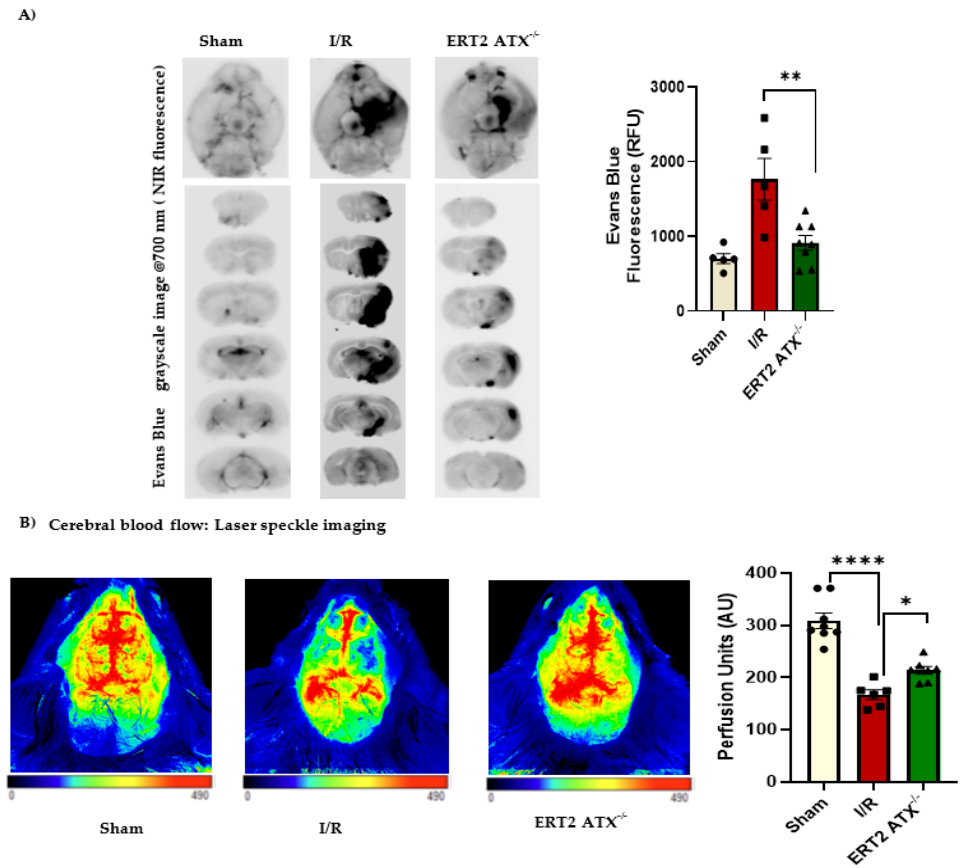
Figure 6. Better functional stroke outcomes observed in ERT2 ATX − / − mice. ( A ) Vascular permeability measured using Evans blue fluorescence. Evans blue fluorescence obtained at 700 nm in the infrared imager represented as grayscale images and quantified as relative fluorescence units (RFU) in sham, I/R, and ERT2 ATX − / − mice brains, n = 5–8. ( B ) Cerebral perfusion was measured with Laser Speckle imaging and representative images are shown for sham, I/R, and ERT2 ATX − / − mice brains. Perfusion units as an arbitrary unit (AU) were used for quantification of cerebral blood flow in the ipsilateral hemisphere of the mice brains, n = 6–8. All values are mean ± SEM. * p < 0.05, ** p < 0.01, and **** p < 0.0001 show significance compared to using ANOVA followed by the Bonferroni post hoc test.